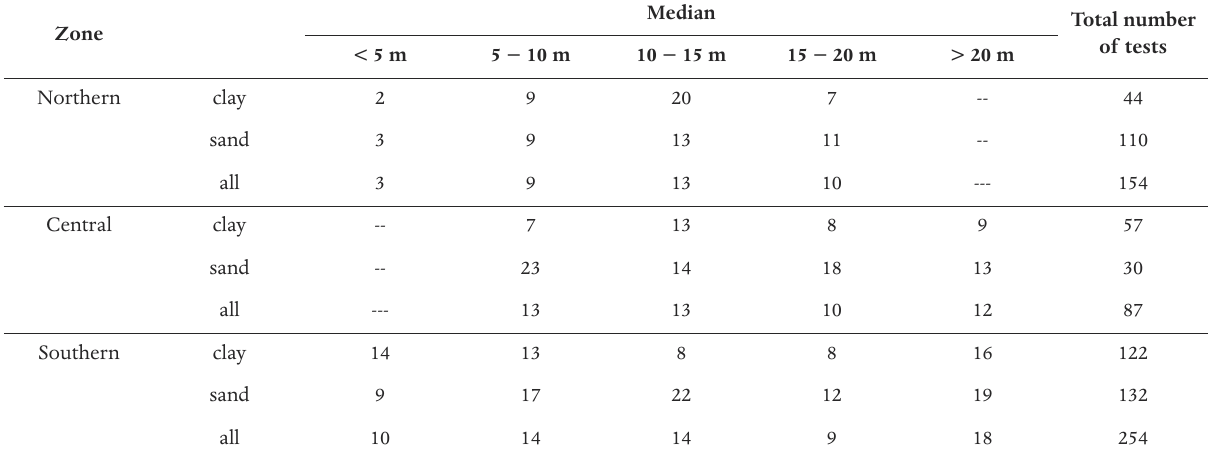
values (N < 50) in the alluvial deposits at different depths for the three SPT SPT